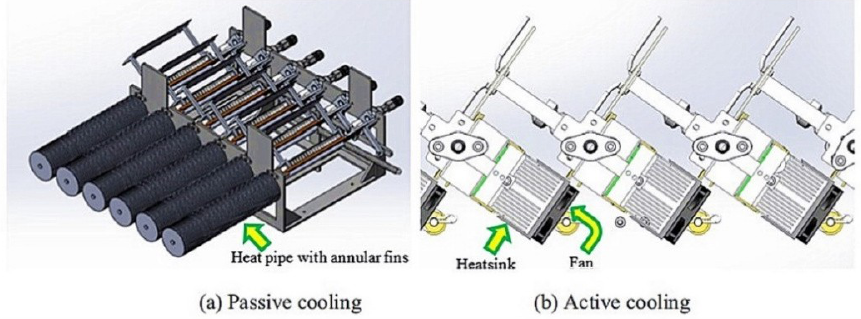
Figure 17. Schematic of two cooling design options: ( a ) passive heat pipe cooling; ( b ) active fan cooling [89].